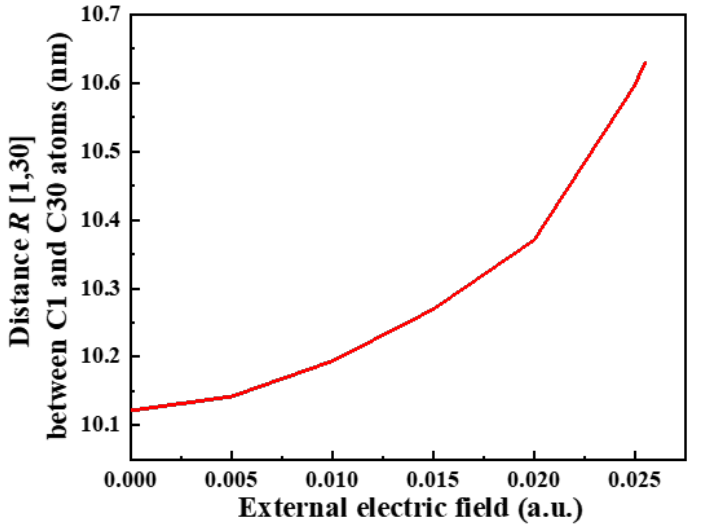
Figure 4. The trend of distance R [1,30] between the C1 and C30 atoms.